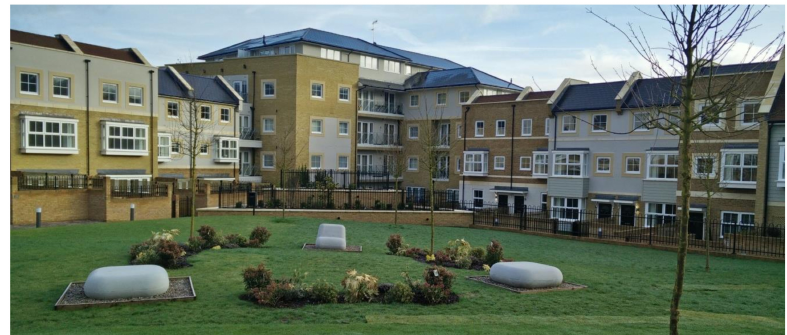
Figure 1. View of the housing development from the courtyard.